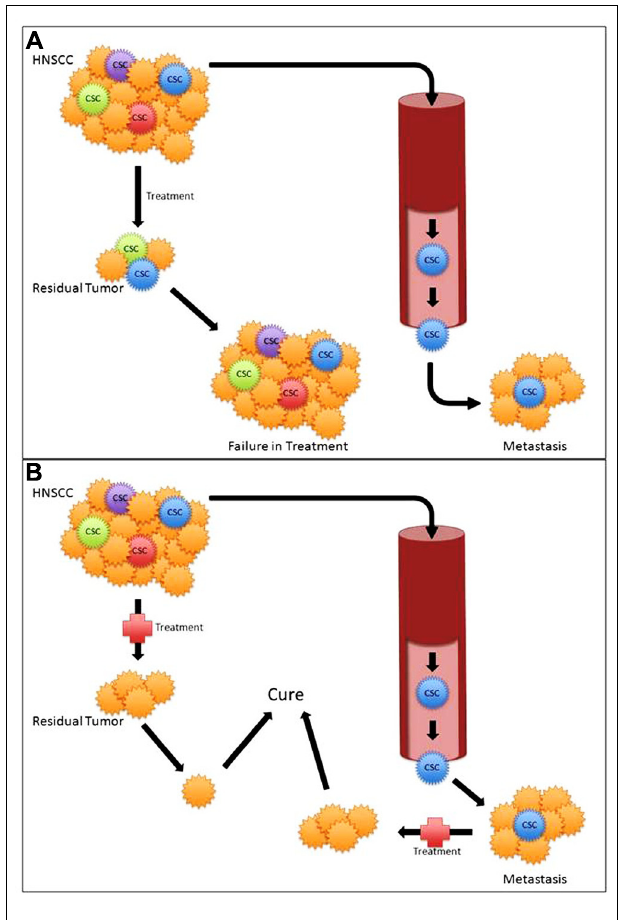
FIGURE 2 | (A) Standard treatment modalities with cancer stem cell (CSC) mediated treatment failure and metastasis. (B) Targeted CSC therapy potentially leading to improved